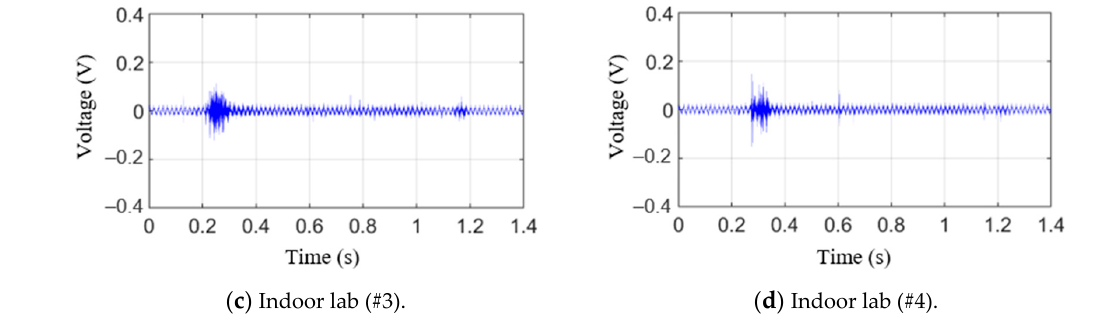
Figure 10. AE raw signal with press process. Table 3. AE parameters from the raw